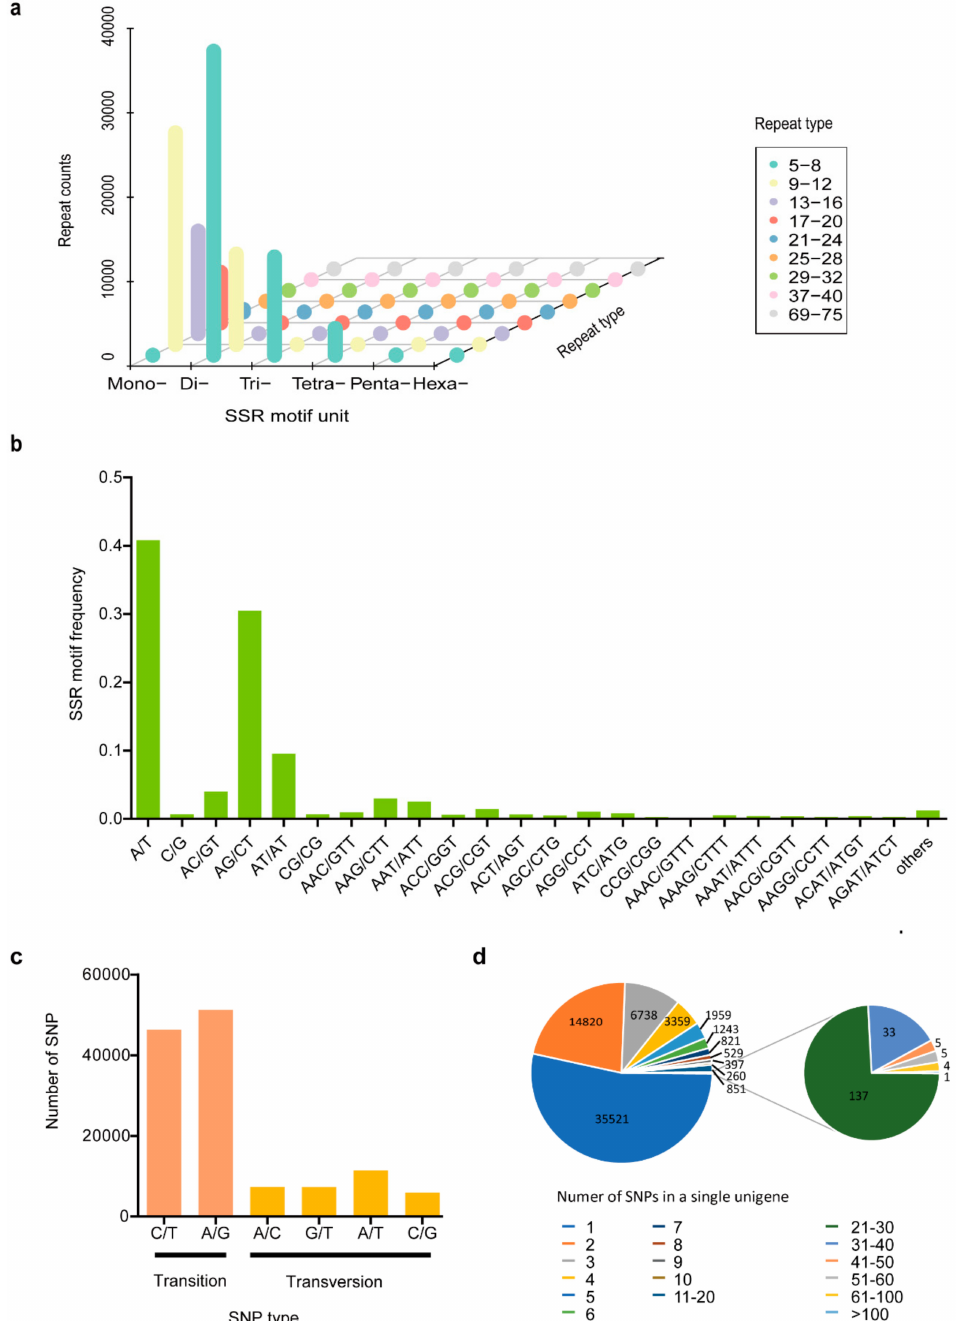
Figure 6. Characterization of the Simple Sequence Repeats (SSRs) and Single Nucleotide Polymorphisms (SNP) markers. ( a ) Distribution of the SSR motifs; ( b ) Frequencies of the classified SSR motifs; ( c ) Classification of SNPs and corresponding numbers; ( d ) The number of SNP-containing unigenes with di ff erent numbers of SNPs in a single